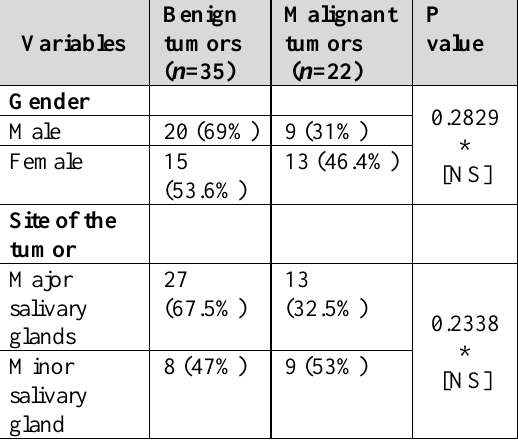
Table 2: Distribution according to gender